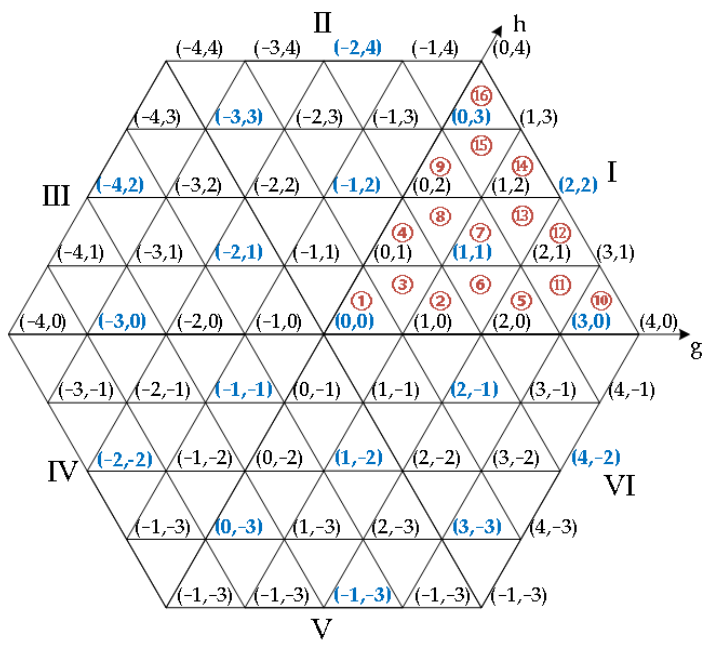
Figure 5. The space vector diagram of a five-level MMC based on the g-h axis.